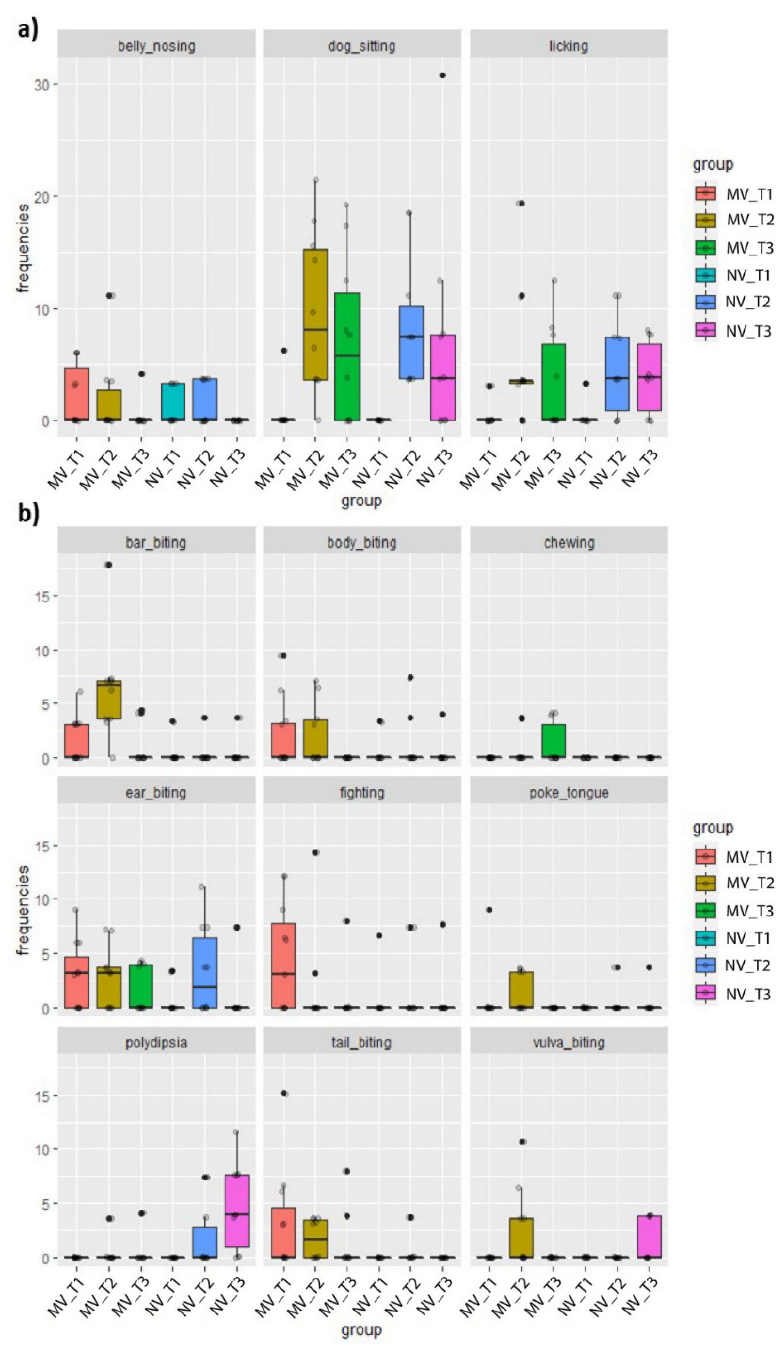
Figure 3. Observed stereotypies in the two buildings at different times. Each behavior was grouped in ( a , b ) according to the observed frequency.